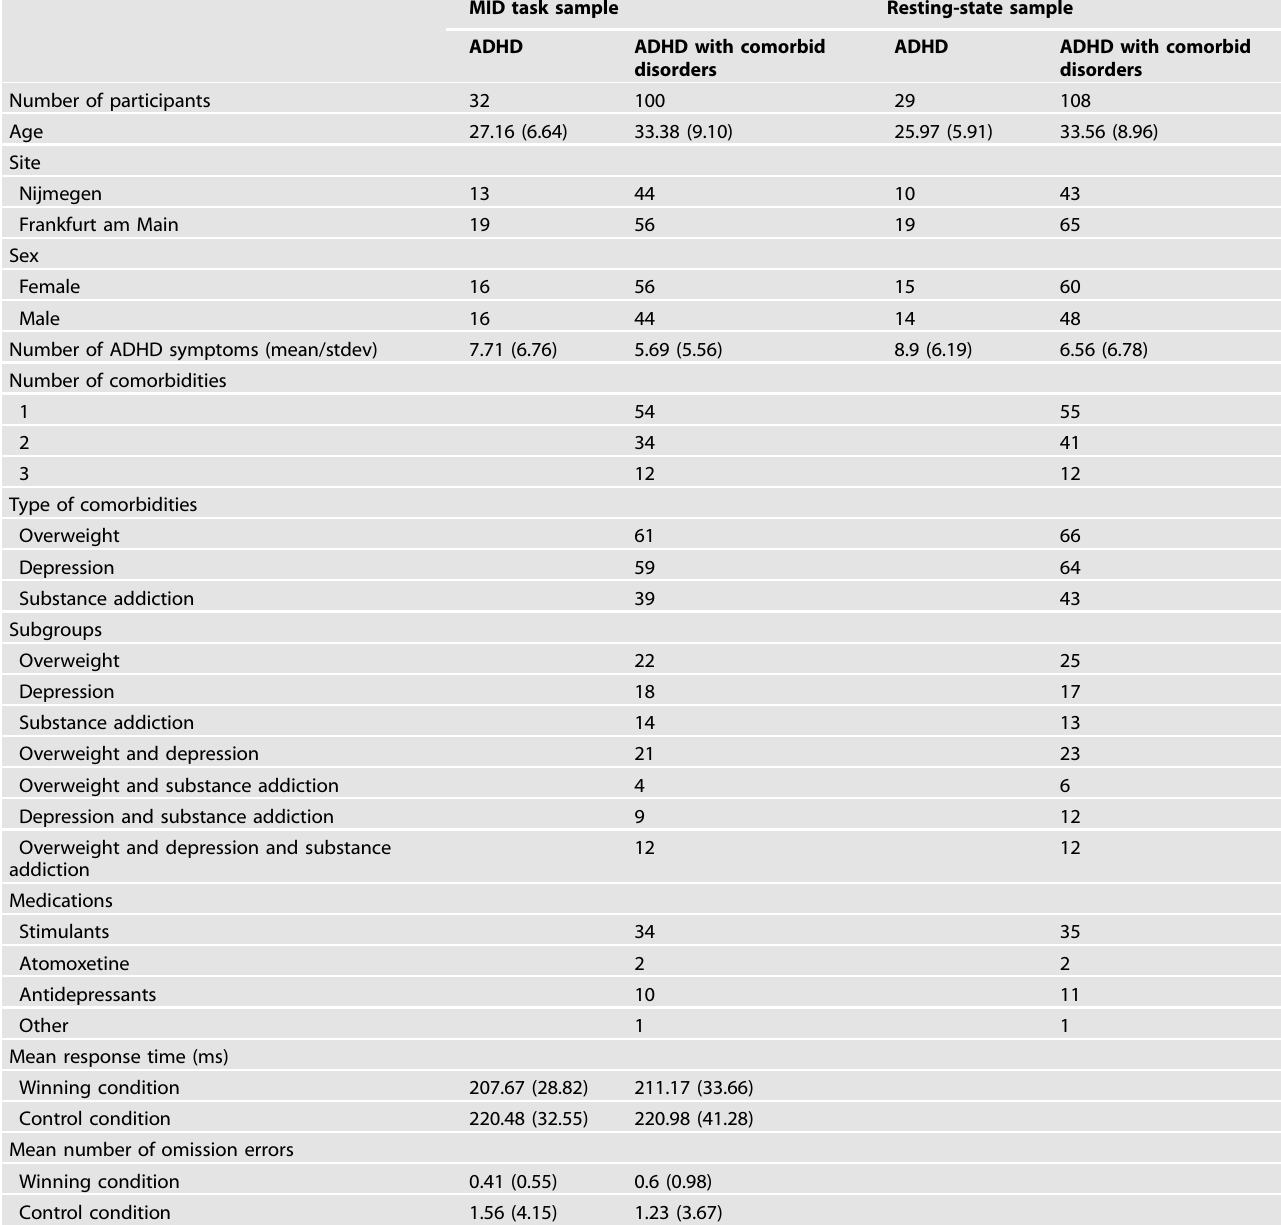
Table 1. Demographic overview with behavioral measures of